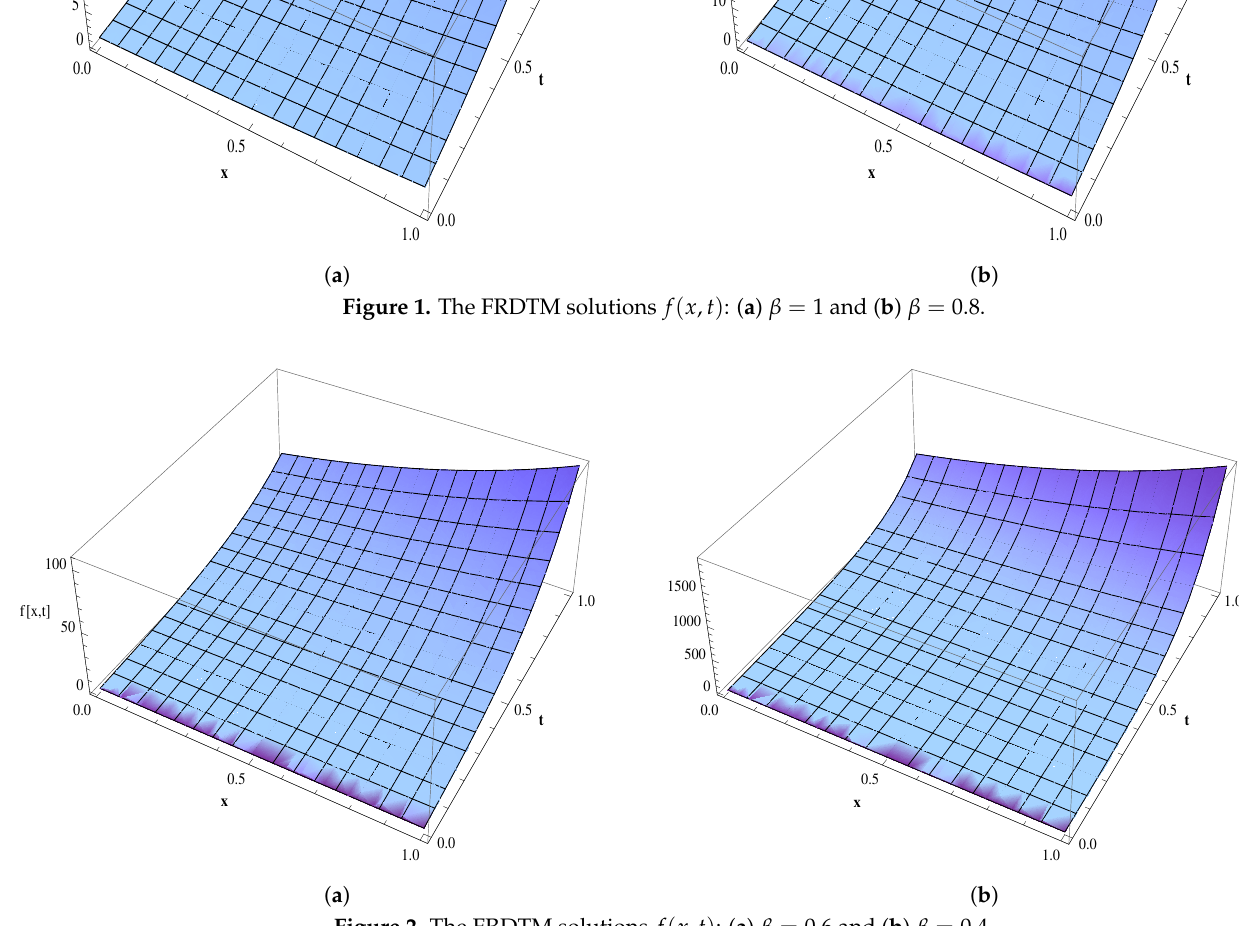
Figure 2. The FRDTM solutions f ( x , t ) : ( a ) β = 0.6 and ( b ) β =